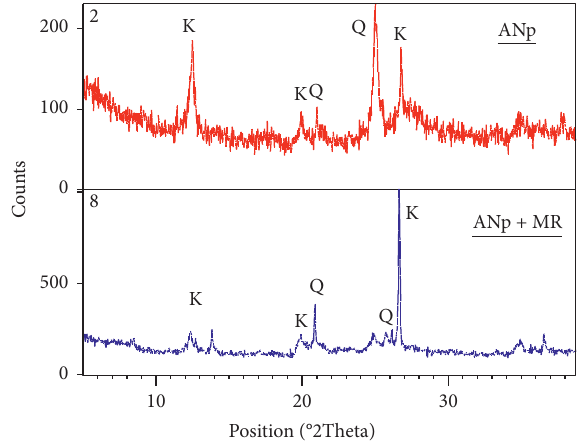
Figure 6: XRD spectra of purified clay before (AP) and after (AP+MR) adsorption. Table 5: Group frequencies (cm − 1 ) and functional groups of the methyl red. Group